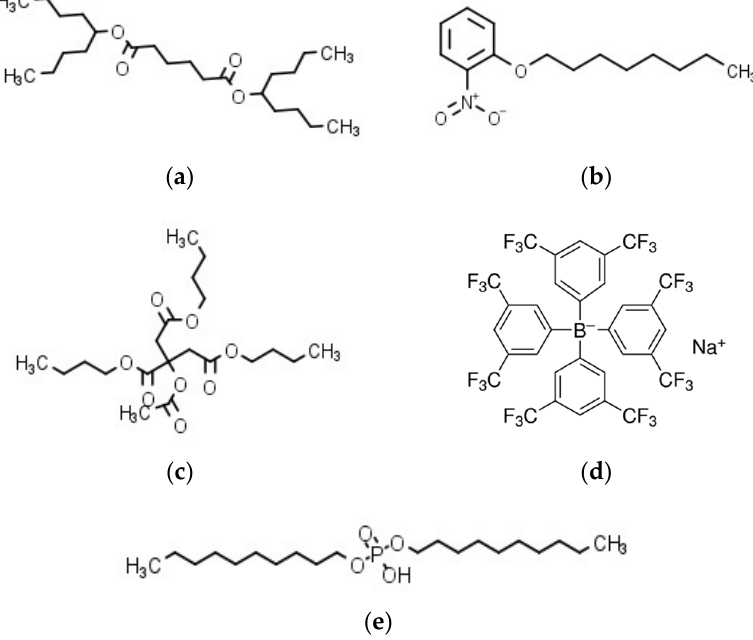
Figure 1. Structures of membrane components: ( a ) BBPA; ( b ) NPOE; ( c ) TBAC; ( d ) Na–TFPB; ( e ) PADE.